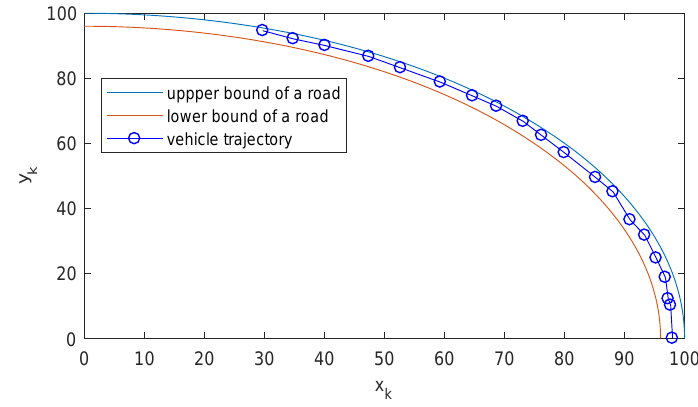
Figure 7. Circular road and an example